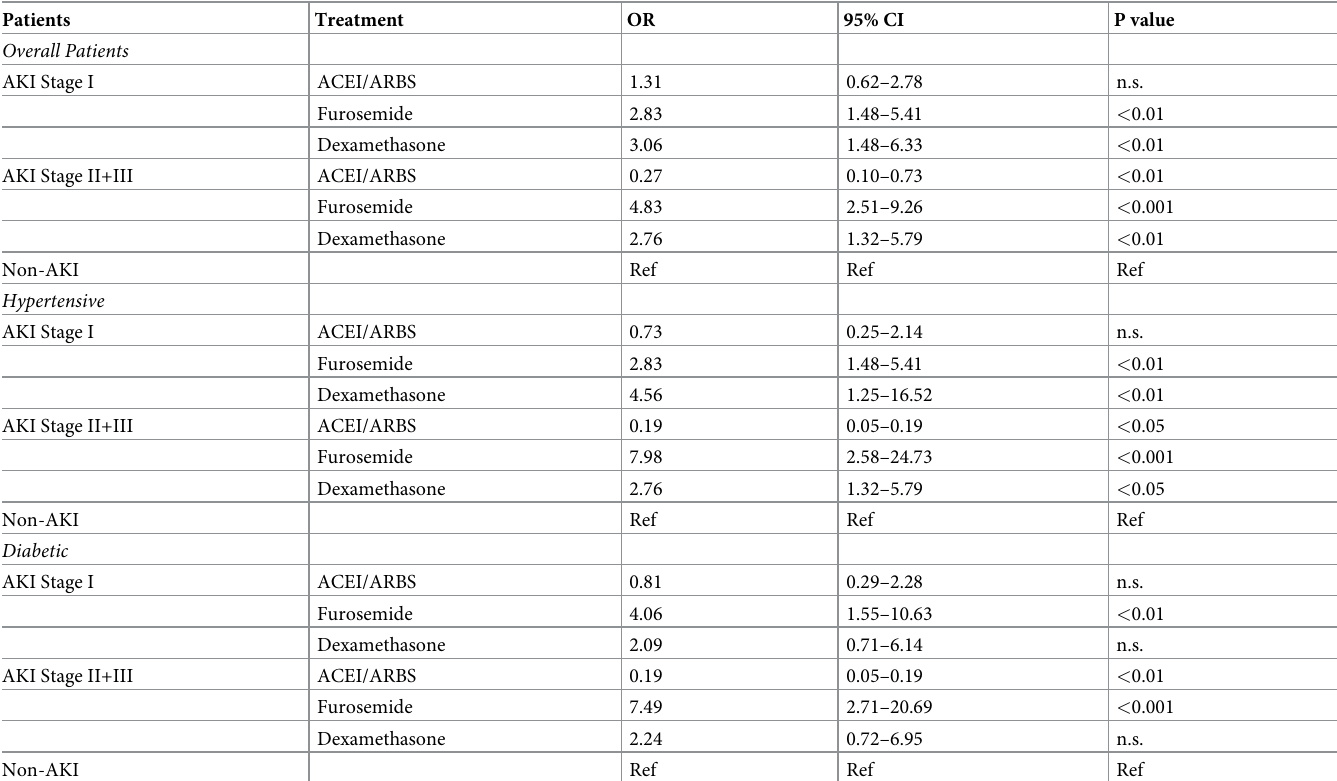
Table 6. Multivariate logistic regression analysis of selected treatments associated with AKI development following adjustment with age.